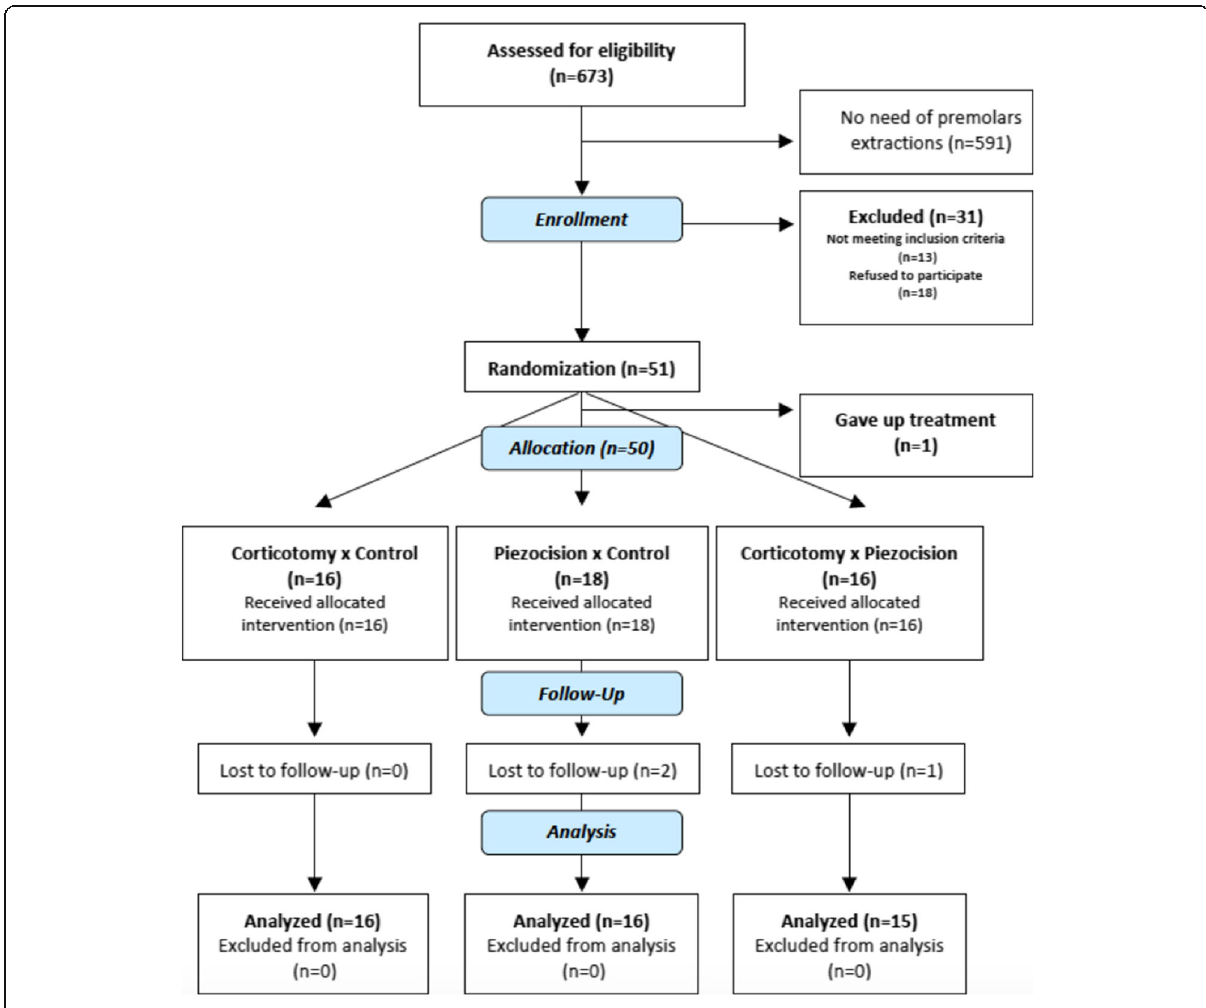
Fig. 1 CONSORT study